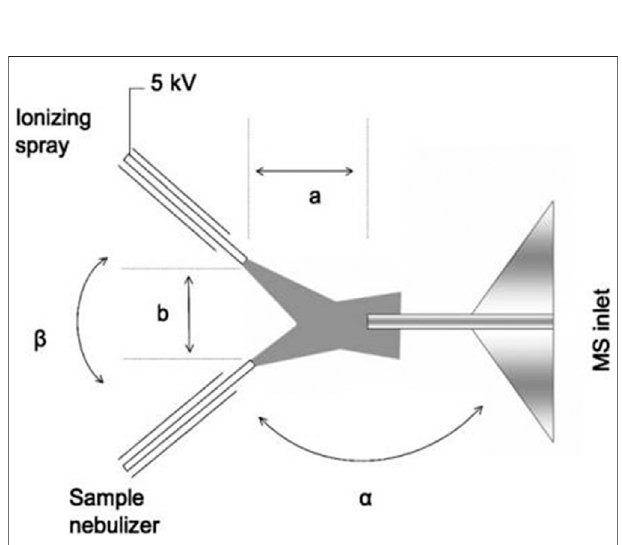
FIGURE 6 | Schematic diagram of extractive ESI (Chen et al.,